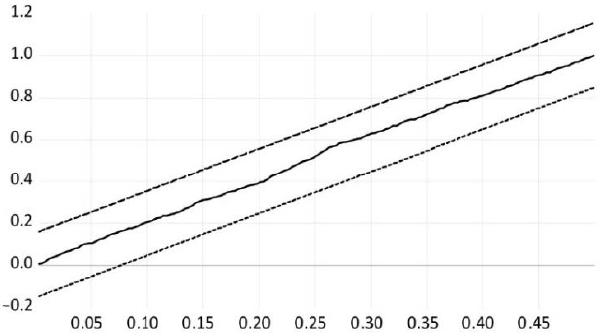
Figure 1. Spectral tests: Normalized integrated spectrum for the USA. Note: This test evaluates the null hypothesis that the data are stationary (white noise). It is based on the normalized integrated spectrum ∑ (cid:3010) (cid:3291) (cid:3286)(cid:3128)(cid:3117) (cid:3435)(cid:3050) (cid:3292) (cid:3439) with the following statistic: 𝑈 (cid:3043) = , where I ( ω ( i )) is the i th maximum. The test statistic (vertical (cid:3435)(cid:3050) (cid:3292) (cid:3439) ∑ (cid:3010) (cid:3289)/(cid:3118) (cid:3286)(cid:3128)(cid:3117) axis) is plotted against its frequency (horizontal axis). If the deviations of the statistic from the p /( n/ 2) line do not exceed ±a (cid:3493)2/𝑛 , the null will not be rejected, where a is set equal to 1.36 for 95% confidence.